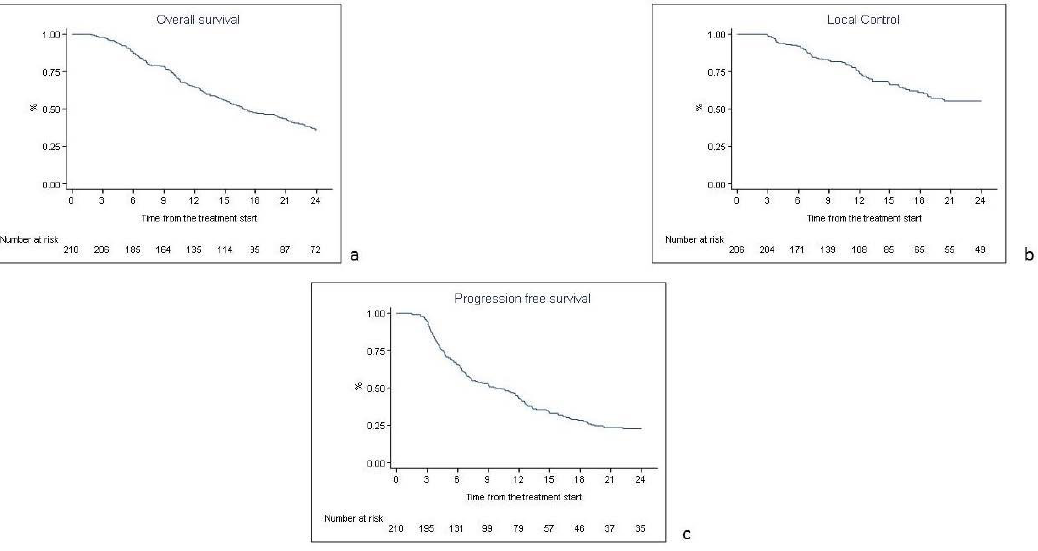
Figure 1. Kaplan Meyer curves for overall survival ( a ), local control ( b ) and progression-free survival ( c